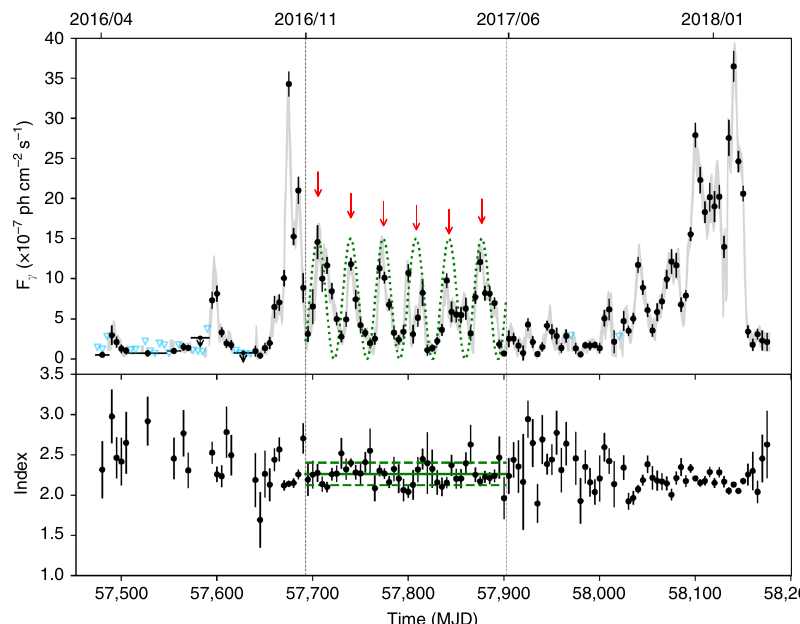
Fig. 1 Analysis of Fermi LAT data for PKS 2247 − 131. In the top panel, a 5-day binned light curve of PKS 2247 − 131 at γ -ray energies of 0.1 – 300 GeV is shown. Each data point is a fl ux measurement (with 1 σ error bar) obtained from each set of 5-day binned data. Flux upper limits (95% con fi dence level; light blue downwards triangles) are also shown when the source was not detected in any 5-day binned data (TS<9). For the group of upper limits at the beginning of the light curve, the source can be detected in enlarged time bins (10 – 40 days; plotted with horizontal bars), while there are still two 20-days upper limits (downwards arrows). Two vertical dashed lines mark the interval MJD 57693 – 57903 during which clear periodic modulation is seen. For clarity, a smooth light curve, constructed by shifting each 5-day time bin one day forward, is over-plotted as a gray curve. Red arrows and the green dotted sinusoidal curve (with a period of 34.5 days) are plotted to help indicate the modulation in the light curve. In the Bottom panel, we show Photon index values obtained from each set of 5-day binned data, in which a power law is used in the analysis. The green line indicates the average value (2.26) of the photon indices during the temporal interval exhibiting the quasi-periodic modulation, and the green dashed lines mark the standard deviation (0.14) range of the data